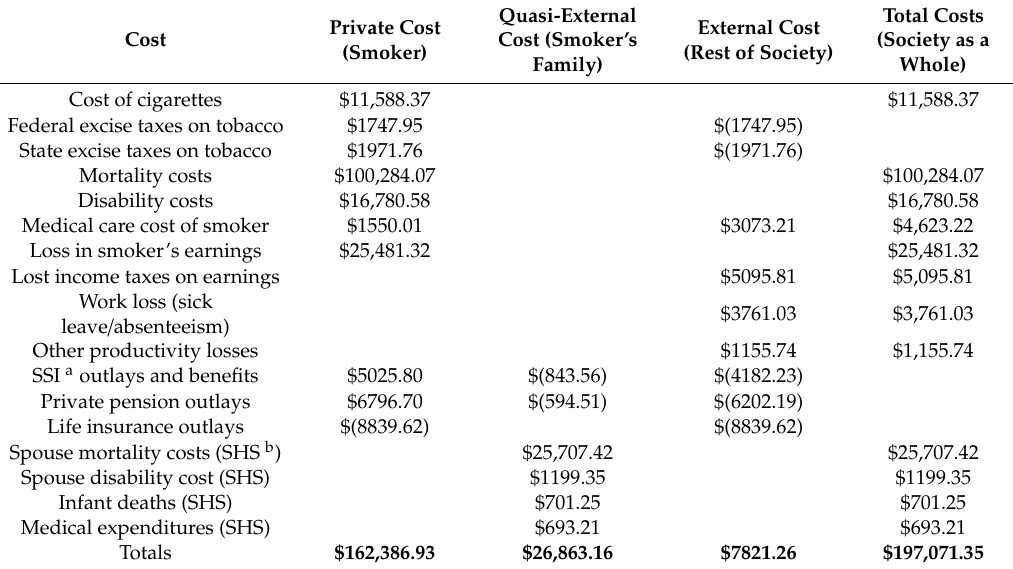
Table 2. Cost of smoking for a smoker aged 18 years: return on investment analysis input parameters.